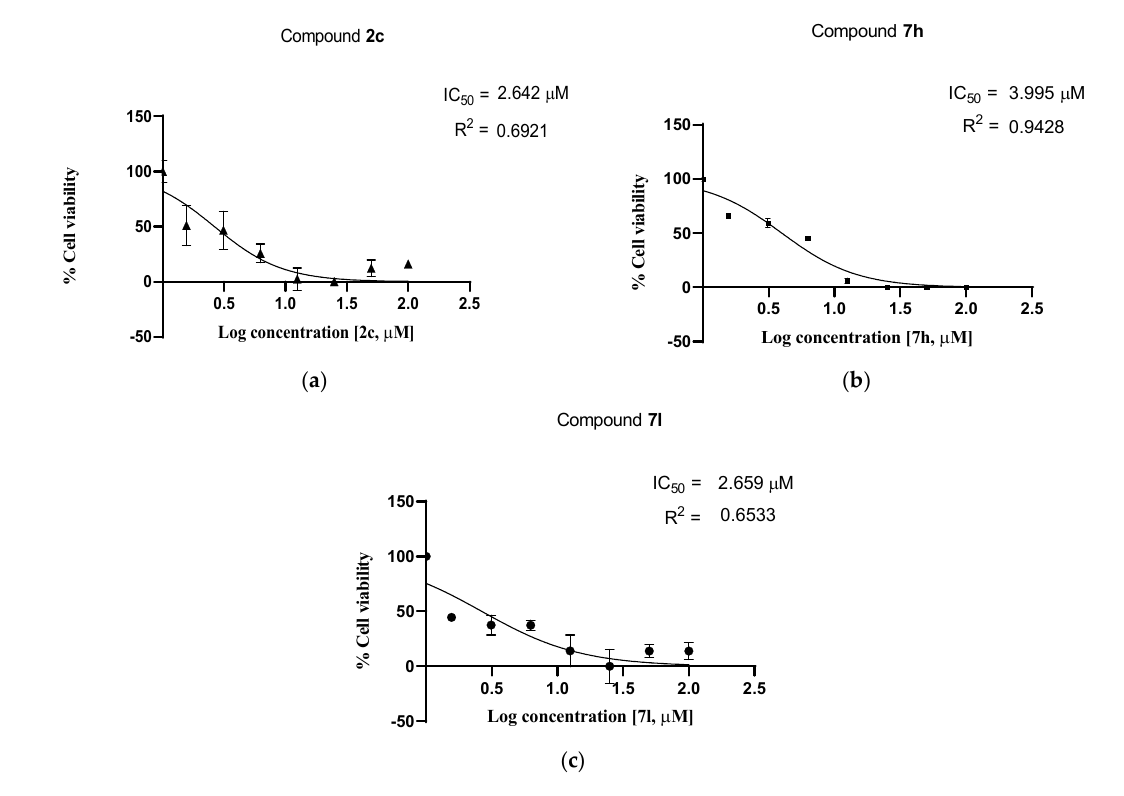
Figure 6. Dose–response curves for the compounds in HeLa cells after 72 h incubation.